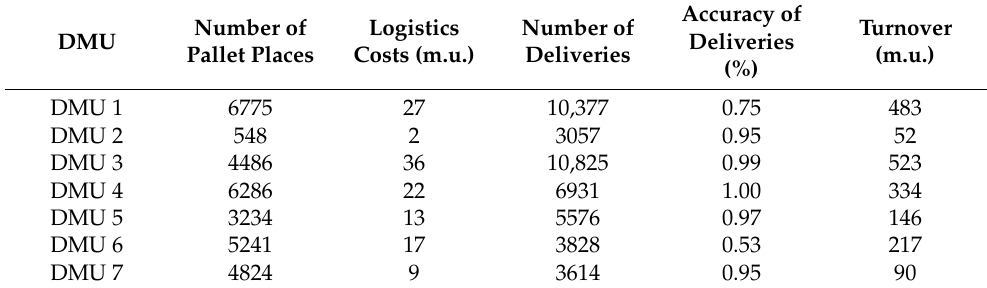
Table 2. Input and output variables for observed